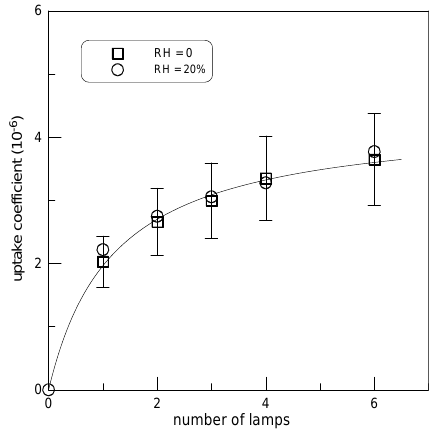
Fig. 7. Uptake coefficient as a function of the irradiation inten- sity (number of lamps switched on): T = 280K, P = 9Torr, sample mass=0.47mgcm − 1 , [NO 2 ] ≈ 2 × 10 12 moleculecm − 3 . The line is Figure 7. drawn to guide the eye.